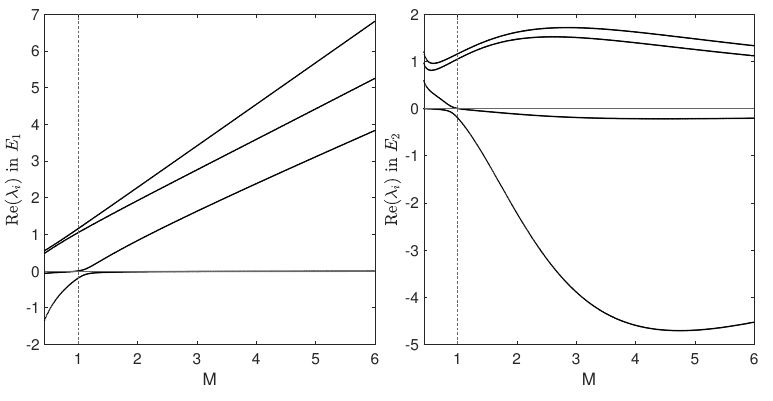
Figure 6. Eigenvalues of the Jacobian J | E increased with respect to the reference case: δ = 4, θ = 0.05, ν = 0 (corresponding to Pr = 1).